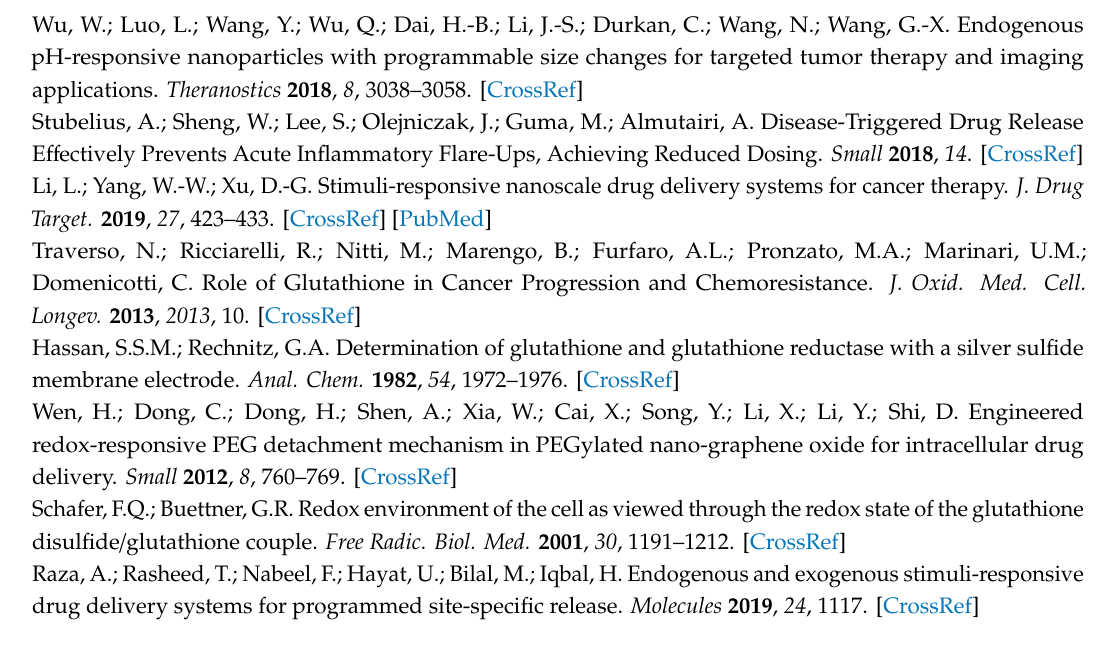
Figure S1. (a) Expression of HER2 in SK-BR-3 and MDA-BM-231 breast cancer cell lines. β -actin served as loading control; (b) Quantification of HER2 protein expression is given as intensity of β -actin-standardized HER2 levels in the